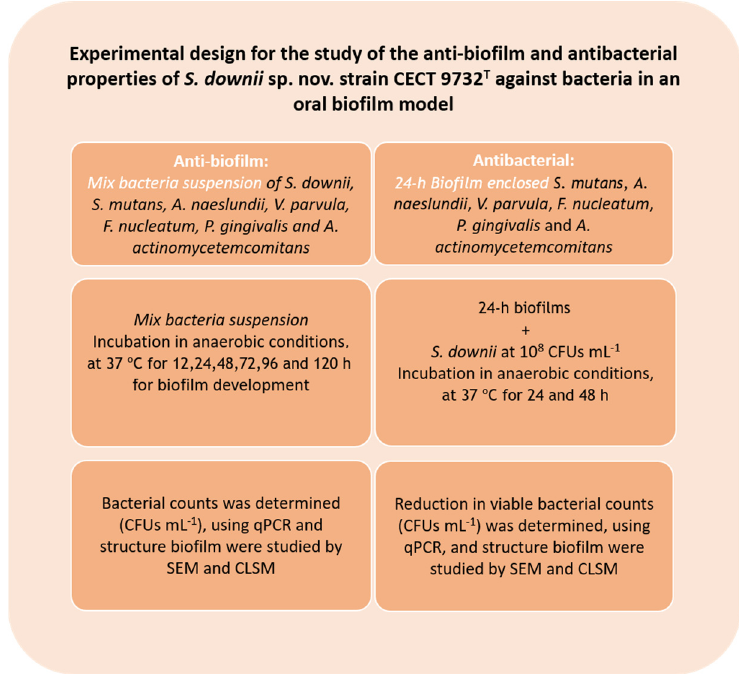
Figure 1. Scheme of the antibacterial assays carried out in the study. For abbreviations, see the